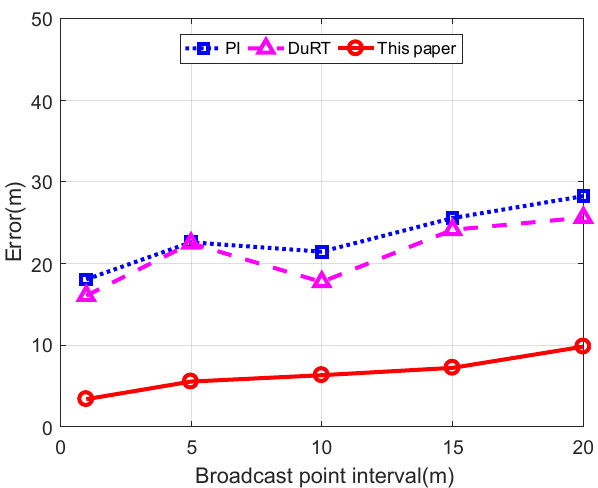
Figure 13. Mean error of the projection of the node on the trajectory determined by different schemes.